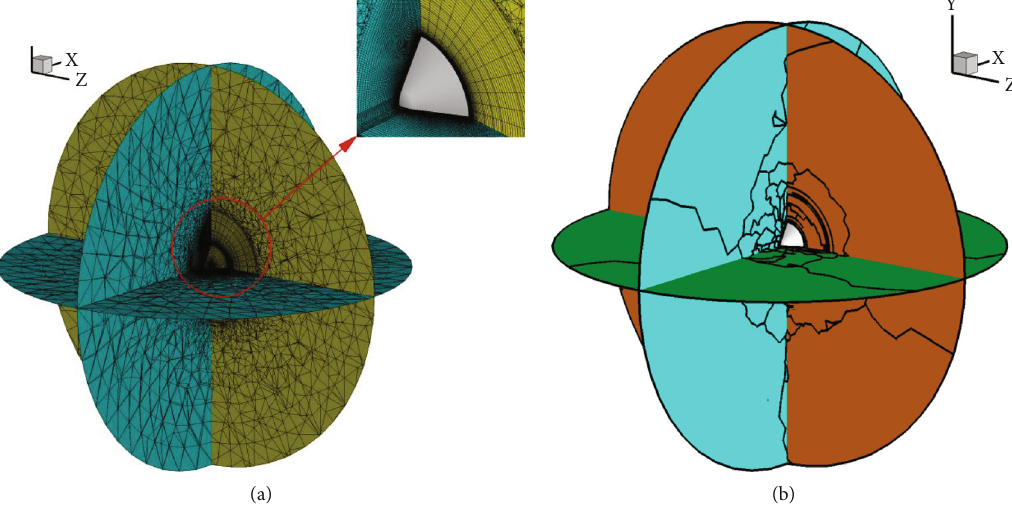
Figure 3: Schematic diagram of grid generation and partition. (a) Three-dimensional grid. (b) Grid partition.